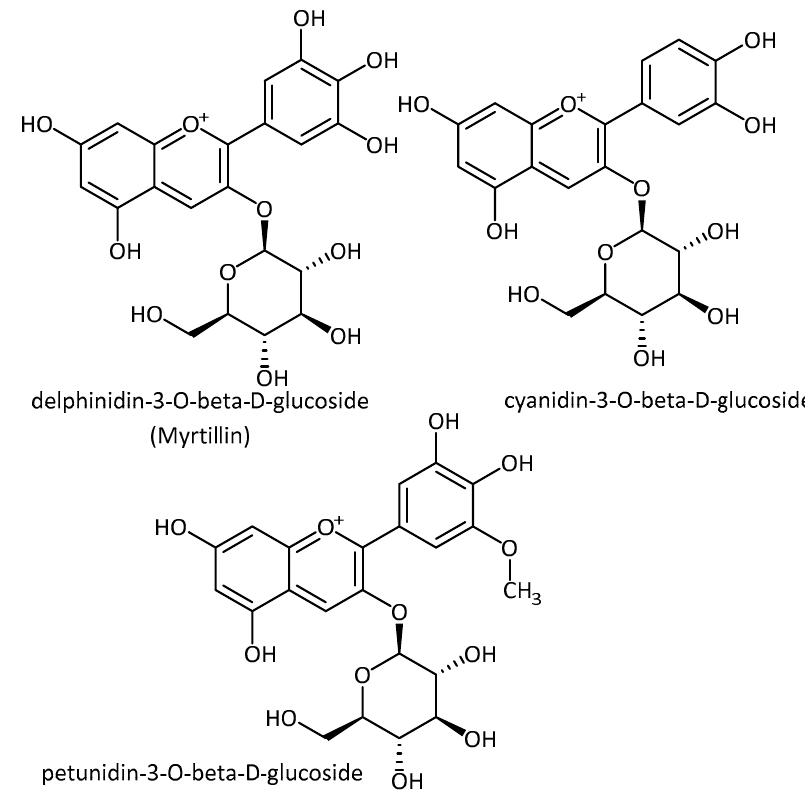
Figure 11. Structure of anthocyanins.